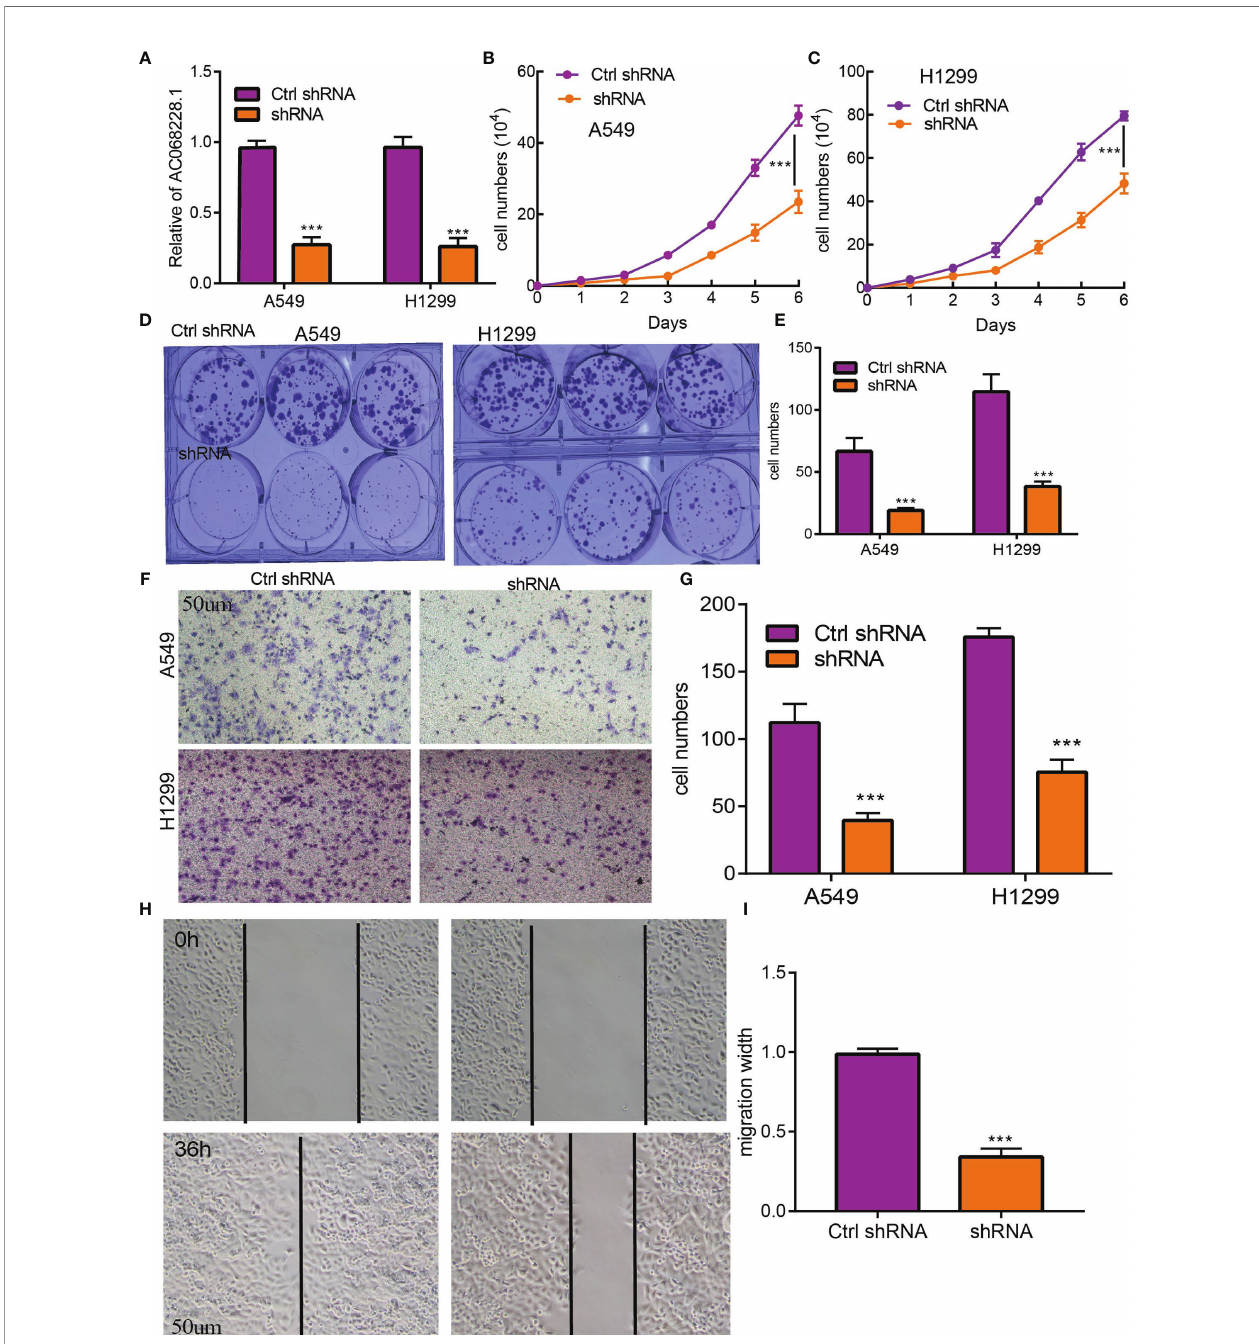
FIGURE 9 | AC068228.1 promotes LUAD cell proliferation, migration, and invasion in vitro . (A, B) Establishment of AC068228.1 knockdown cell lines in A549 and H1299 cells veri fi ed by real-time RT-PCR. (C – E) Knockdown of AC068228.1 signi fi cantly inhibits cell proliferation in A549 and H12995 cells as measured by a growth curve and colony formation. (F – I) knockdown of AC068228.1 dramatically inhibits A549 and H1299 cell migration ability examined by transwell and wound healing assays.